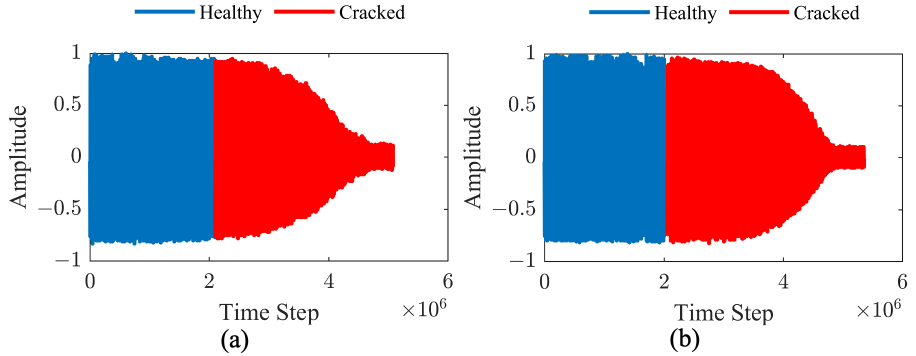
Figure 8. ‘Healthy’ and ‘cracked’ labeling of the ultrasonic signals for ( a ) K t 1 and ( b ) K t 2 .